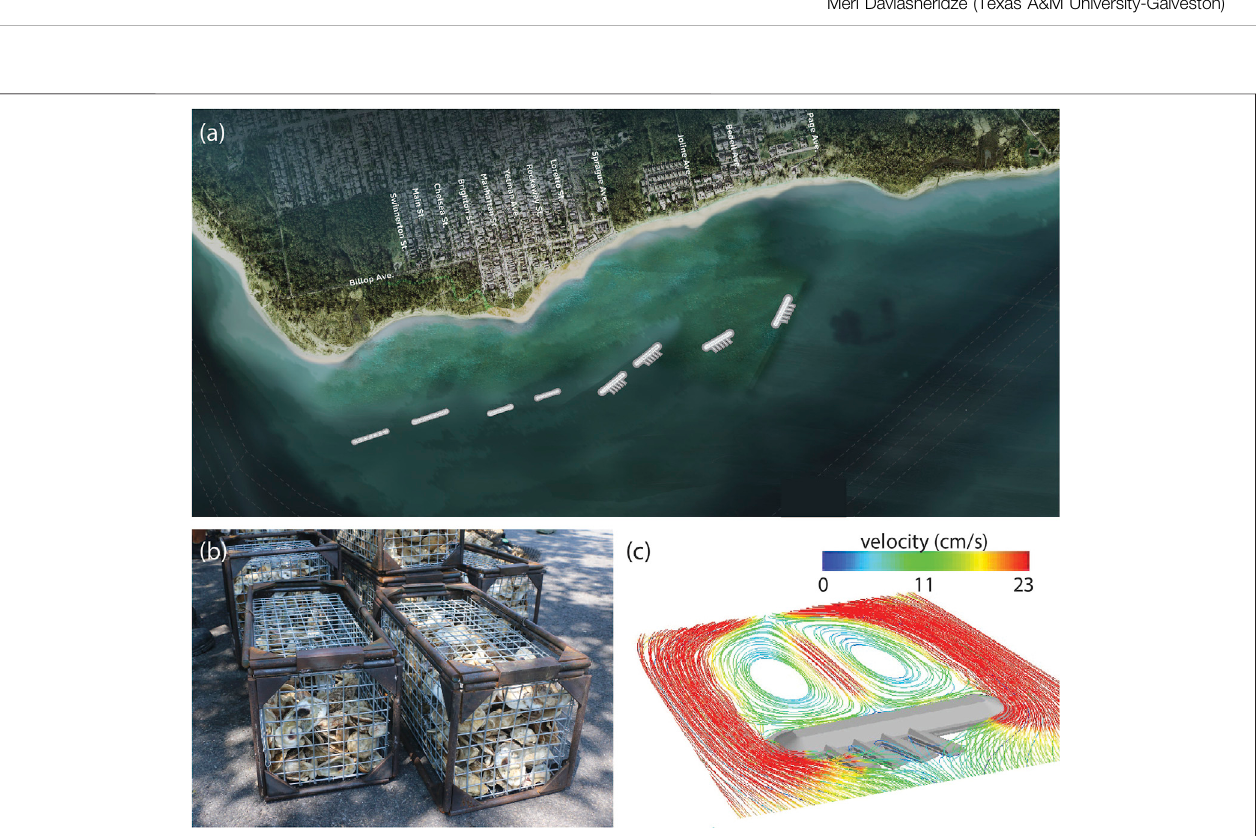
FIGURE2|(A) TheLiving Breakwatersproject willconstructaseries ofbreakwaters inRaritanBay, offshoreofStaten Island. (B) Thebreakwaters aredesigned to provide habitat for marine life, including oysters. (C) Sample breakwaters (shown in gray) include a main breakwater plus “ reef streets ” angled outward. These were tested using computational fl uid dynamics modeling to evaluate and optimize designs for avoiding scour and sedimentation.